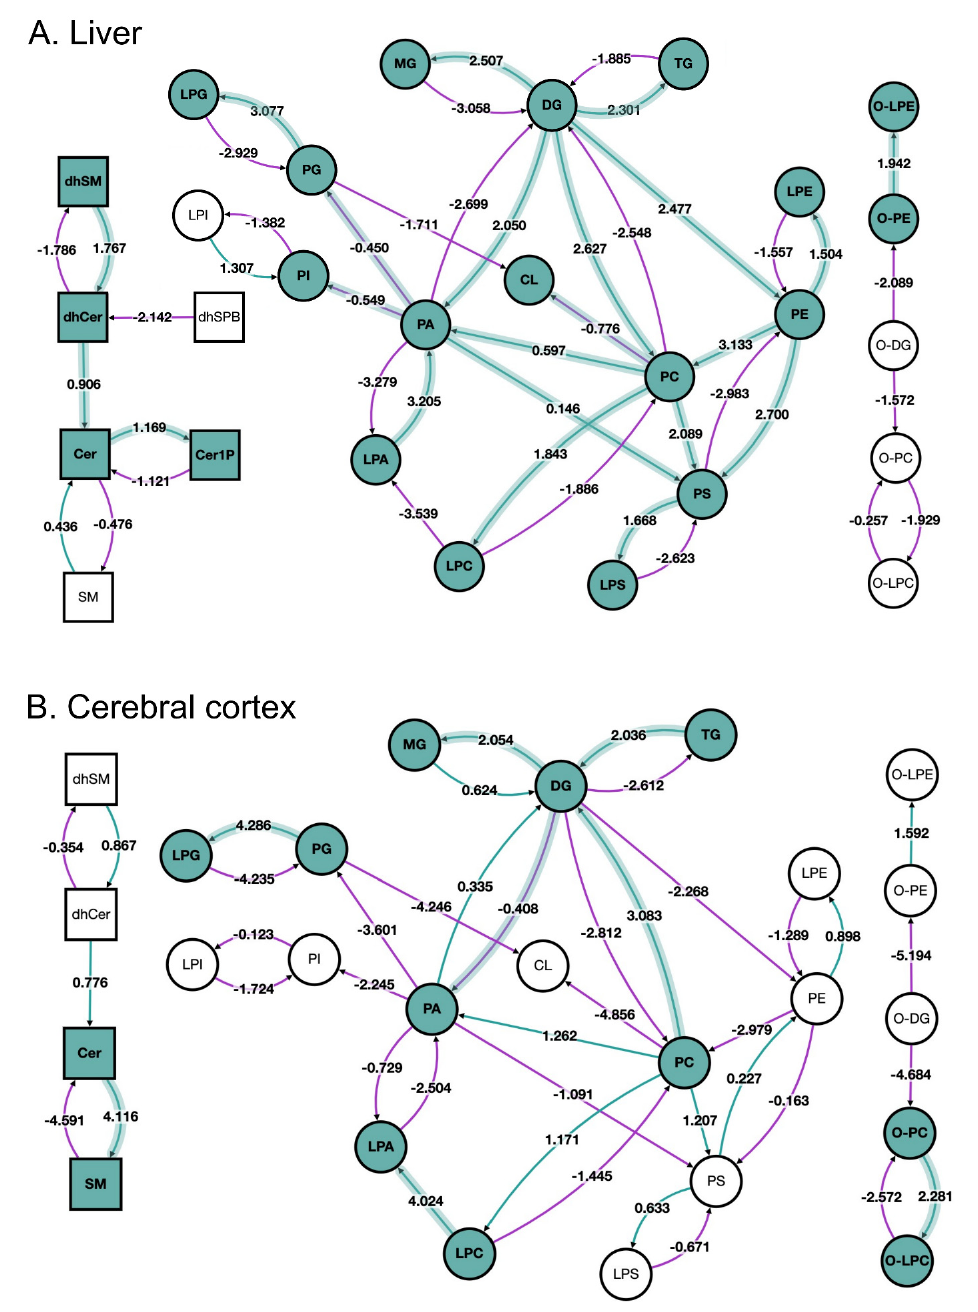
Figure 2. BioPAN lipid networks. Lipid network graphs exported from BioPAN for the liver ( A ) and the cerebral cortex ( B ) of aged mice compared to young mice 17 . Green nodes correspond to active lipids and green shaded arrows to active pathways. Reactions with a positive Z score have green arrows while negative Z scores are coloured purple. Pathways options: aged condition of interest, young control condition, lipid type, active status, subclass level, reaction subset of lipid data, p value 0.05, and no